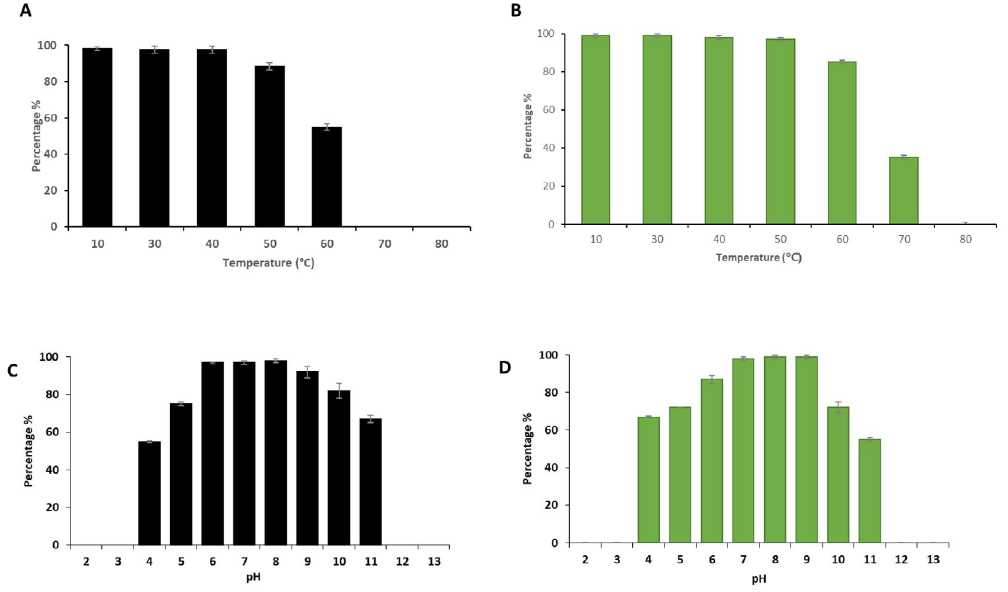
Fig. 3. Thermal and pH tolerance test of phages vB_SauM-EG-AE3 and vB_EfaP-Ef01. (A-B) Thermal tolerance, and (C-D) pH stability of vB_SauM-EG-AE3 and vB_EfaP-Ef01 phages, respectively. Temperature experiments were performed for 1 h at pH 7. pH tolerance was performed for 60 min at 37°C. Data showed the percentages of the remaining phages after each treatment as normalized from the control. Data shown are the mean of three replicates and error bars show the deviation in the